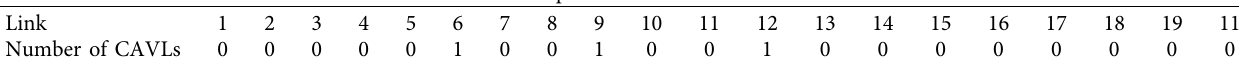
Table 3: Optimal scheme of